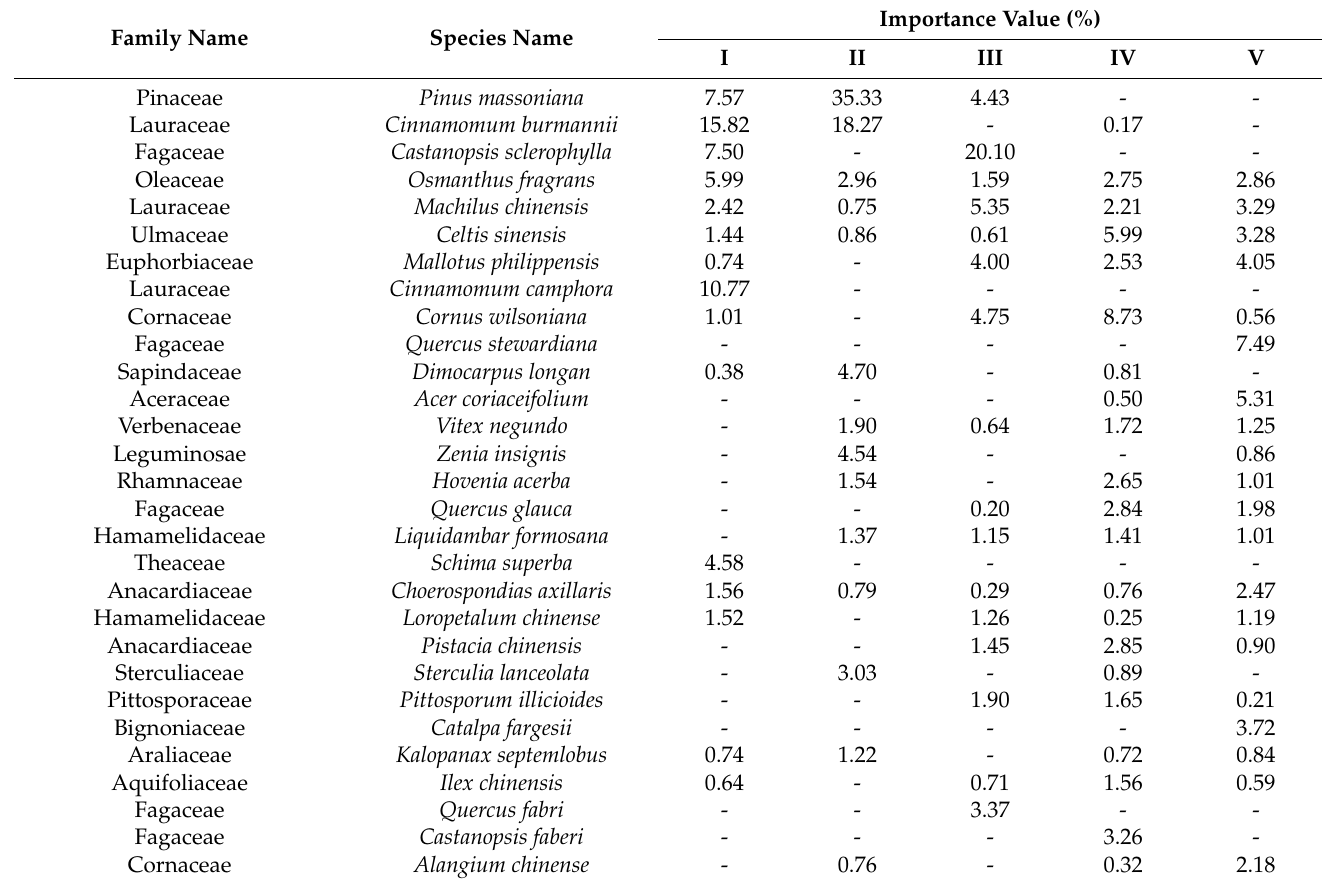
Table 2. The species and importance values of woody plants in areas with different rocky desertifica- tion